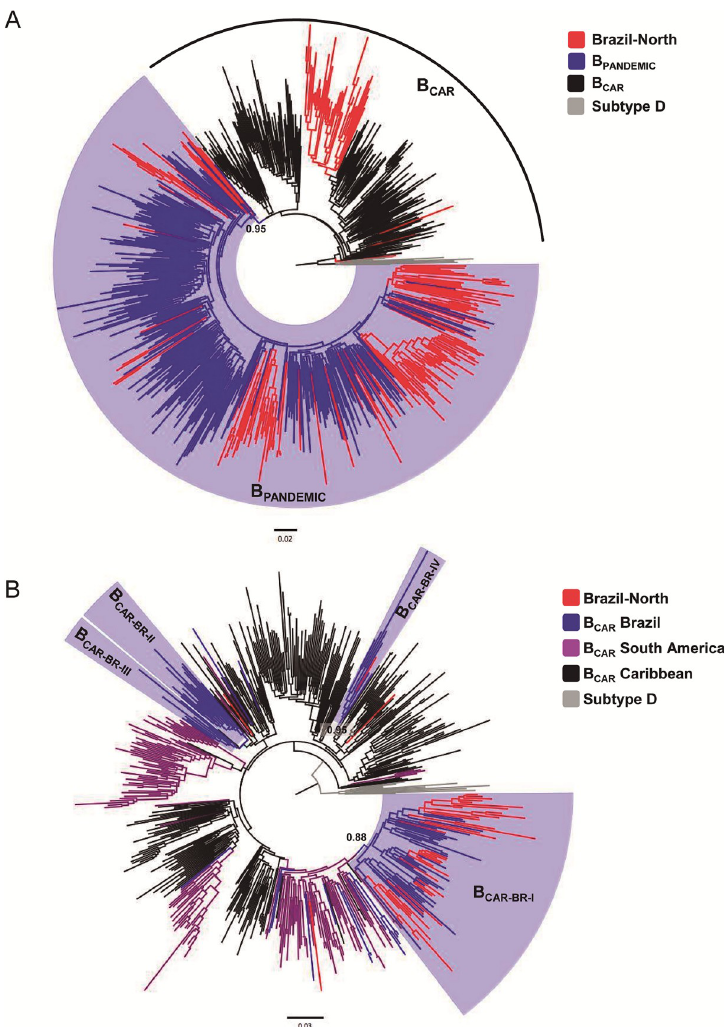
Fig 2. Maximum-likelihood (ML) phylogenetic analyses of HIV-1 subtype B PANDEMIC and B CAR strains identified in Northern Brazil. (A): A total of 206 HIV-1 subtype B sequences from this study (179 from Amazonas, 18 from Rondoˆnia, 9 from Roraima, depicted in red) was combined with 300 previously described viral strains representative of the B PANDEMIC (depicted in blue) and 200 B CAR lineages (black color). (B): The 45 B CAR sequences identified in blood donors from Amazonas, Rondo ˆ nia and Roraima (depicted in red) were combined with previously identified viral strains representative of the major B CAR lineages circulating in Brazil (blue color), Northern South America (French Guiana and Suriname) (purple color) and the Caribbean (Hispaniola, Jamaica and Trinidad and Tobago) (black color).